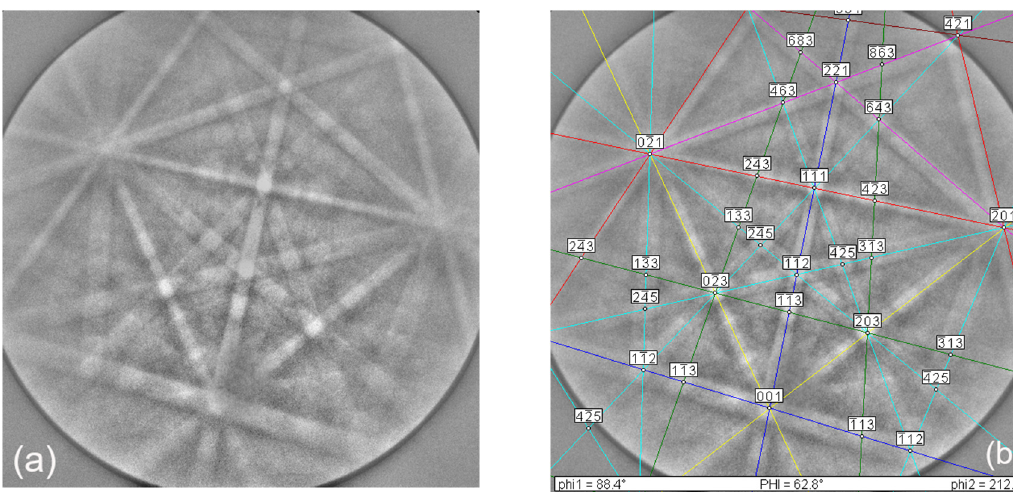
Figure 5. Representative EBSD pattern ( a ) of a manganese-containing inclusion from sample PD-NC1, indexed as neltnerite ( b ).